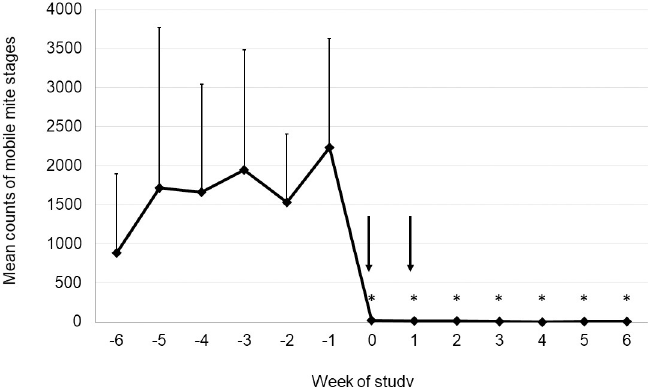
Fig 1. Arithmetic mean counts of mobile mites in traps. Counts in Weeks 0 through 6 differed significantly from mite counts in Week -1 ( � P < 0.0001).